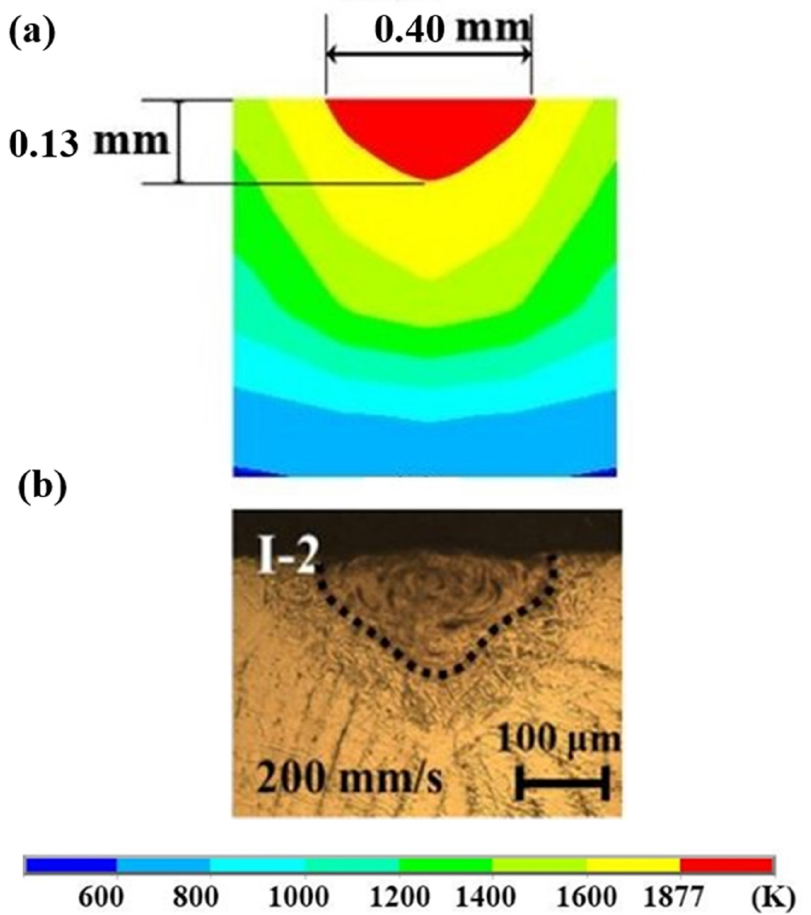
Figure 4. Comparison of ( a ) computed and ( b ) experimental melt-pool shape and size.